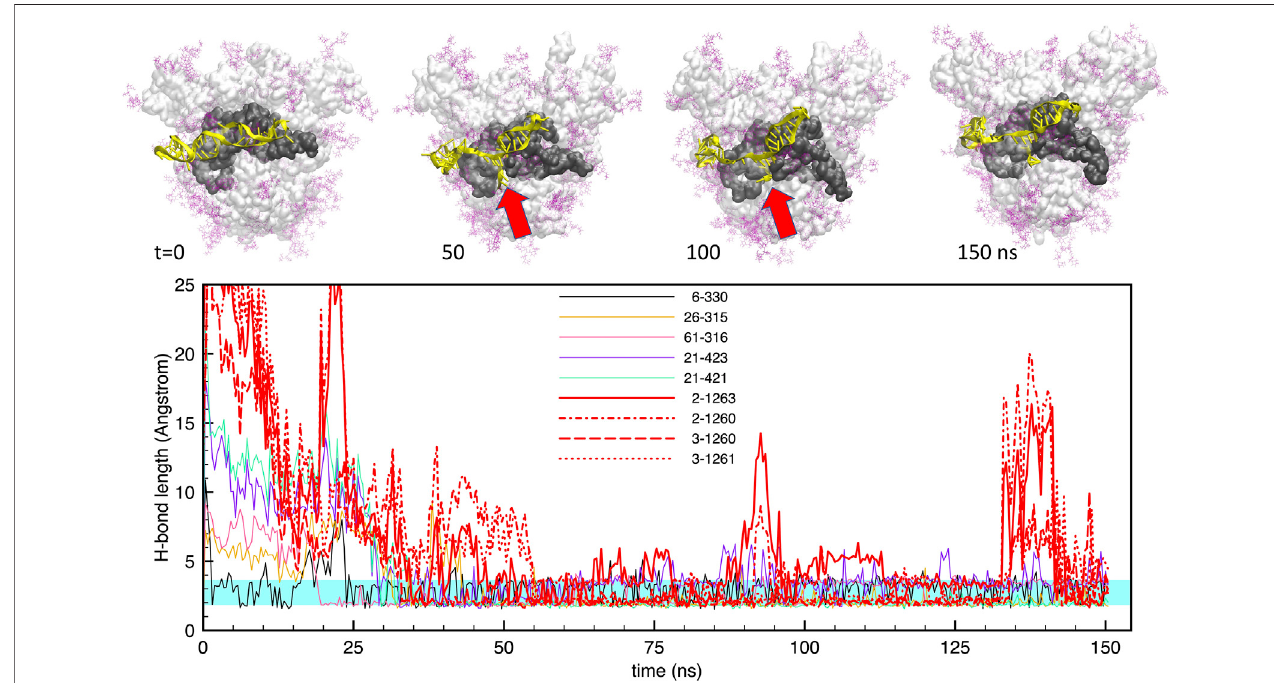
FIGURE3| EvolutionofthestructureandhydrogenbondsformedbytheDNAapta1(51-nt)interactingwiththeS-proteintrimerintheclosedconformation. Lower panel. Time plot of the major H-bonds formed by nucleotides (numbers 1 – 51) and S-protein residues (numbers > 300). Thin lines indicate the H-bonds between the aptamer and the RBD of monomer one; the thick red lines indicates the four extra H-bonds with the RBD of monomer 2 (times t ≃ 50 – 125 ns. The cyan shaded band ̊ indicates the typical interval of H-bond length (2.4 – 3.6 A ). Upper panel. Snapshots of the aptamer-S-protein contact, at times t (cid:2) 0,50, 100, 150 ns DNA is depicted inyellow;protein surfacein lightgrey, withthe RBD ofmonomer one indark grey; glycansin purple. The red arrows indicates the site oftheextra H-bonds with the RBD of monomer 2. The atomic structures are tilted by about 30deg with respect to the central symmetry axis of the S-protein.